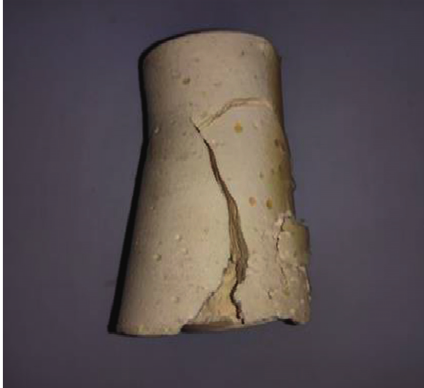
Figure 9: Failure response of high density.